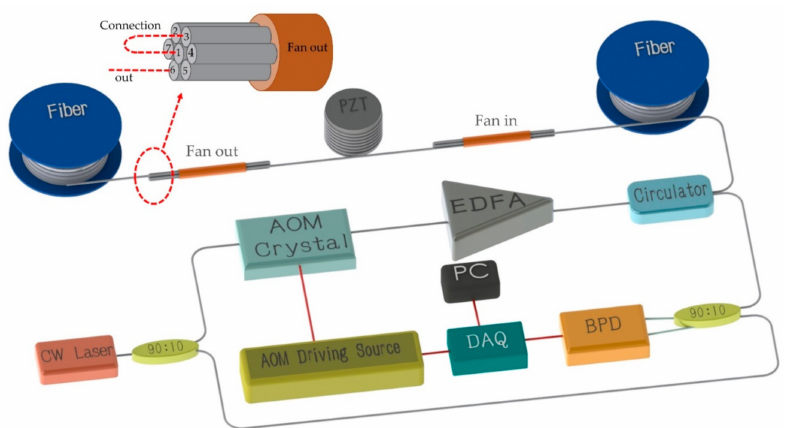
Figure 4. MCF assisted phase-sensitive time-domain reflectometry ( Φ -OTDR) System setup. CW